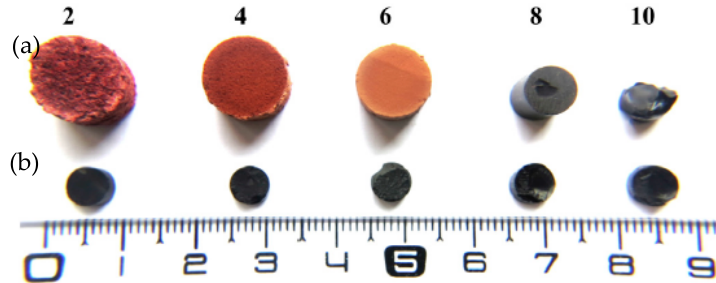
Figure 11. Tannin-formaldehyde gels prepared with surfactant ( a ) top view, and without ( b ) bottom view. Reprinted with permission from reference [98]. Copyright 2011 Elsevier.